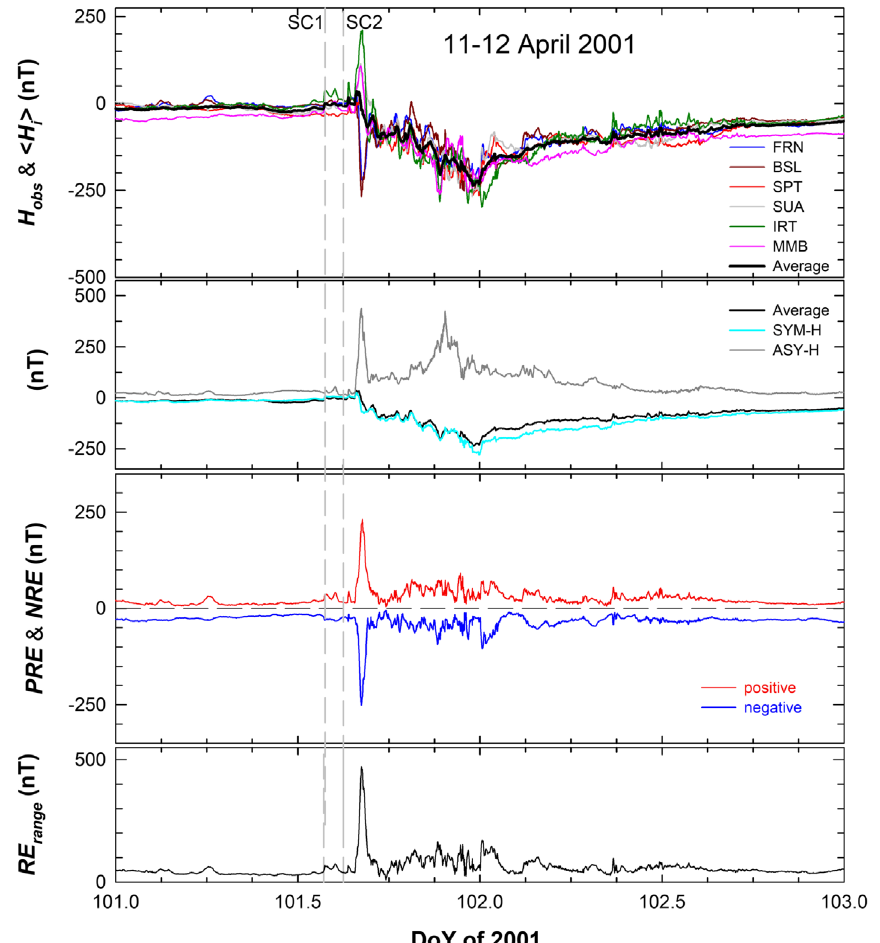
Fig. C.3. The event on 11 – 12 April 2001 (event